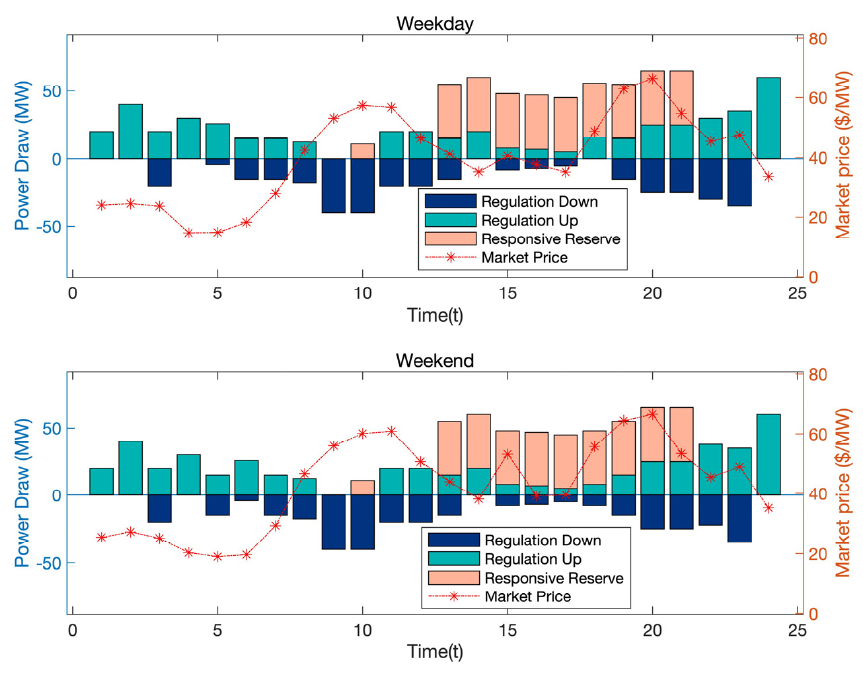
Figure 7. Comparison of regulation and responsive reserve result of Audi e-tron.